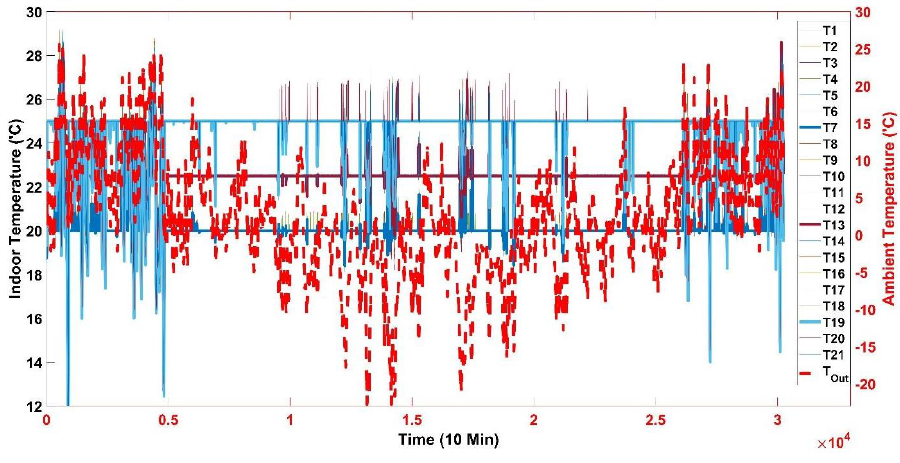
Table 4. GA Designing